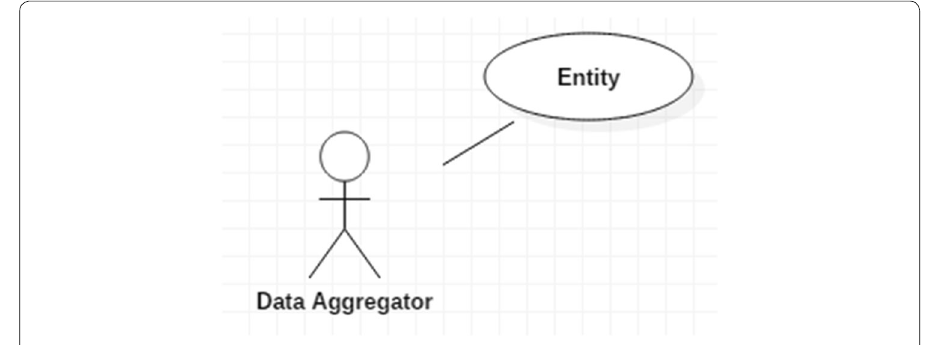
Fig. 7 Entity-Case Diagram